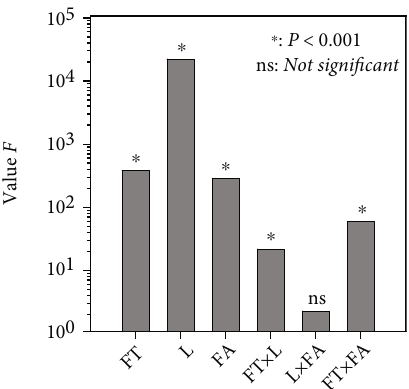
Figure 18: Signi fi cance test of internal friction angle considering interactions.